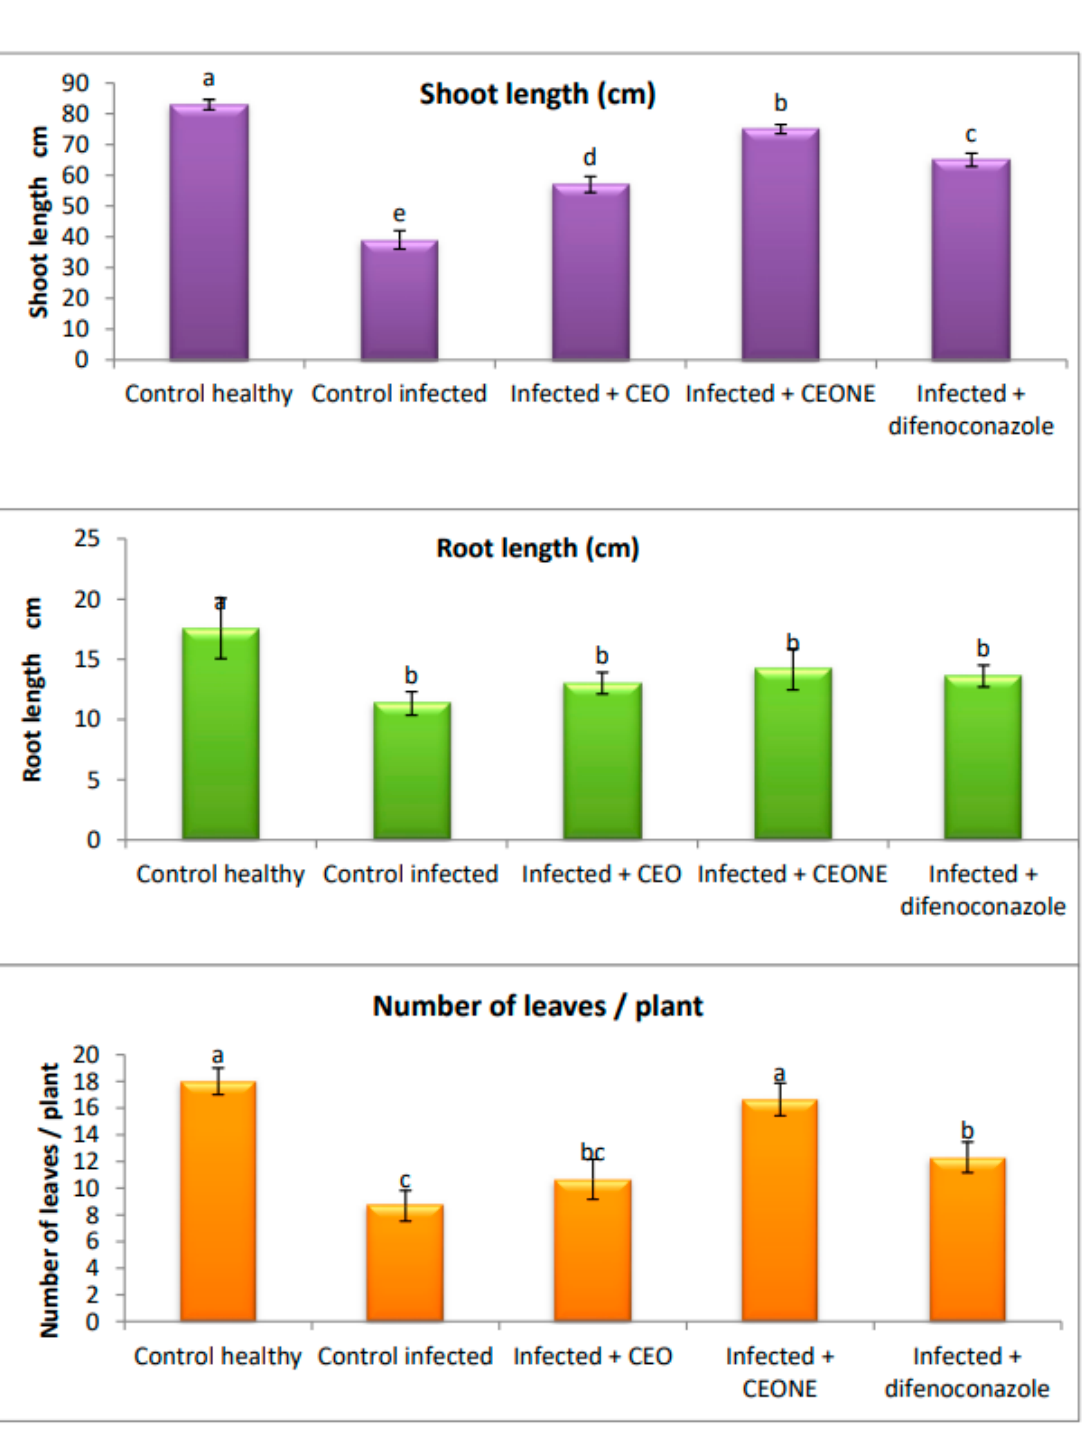
Figure 6. E ff ect of CEO and CEONE on vegetative growth of C. carvi metabolic indicators. Le tt ers Figure 6. Effect of CEO and CEONE on vegetative growth of C. carvi metabolic indicators. Letters a,b,c,d,e mean power of signi fi cance. a,b,c,d,e mean power of